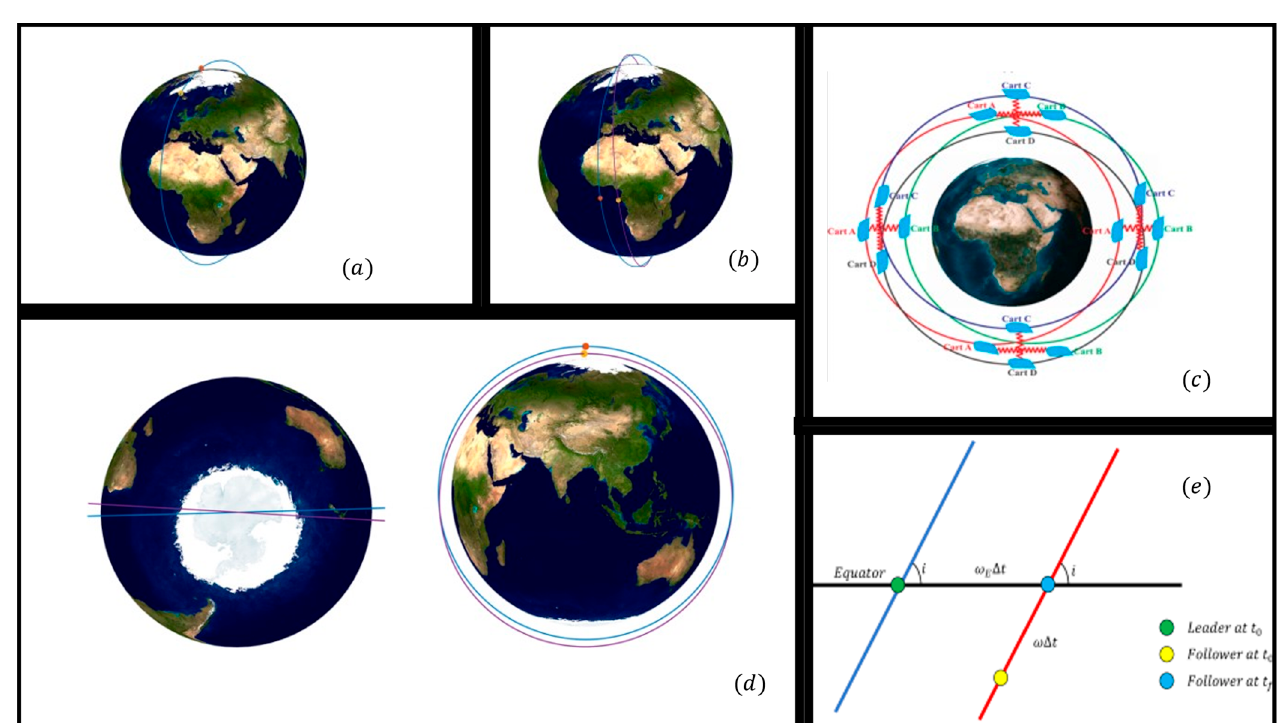
Figure 3. Chief-deputy classification ( a ) leader-follower, ( b ) pendulum, ( c ) cartwheel, ( d ) helix configuration, ( e ) same-ground track.